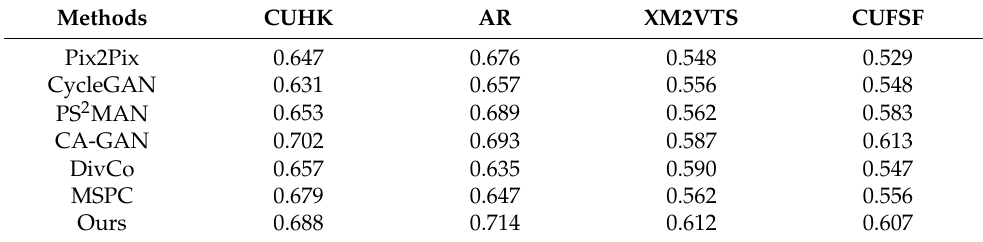
Table 2. SSIM comparison of photos synthesized by different models on the data.